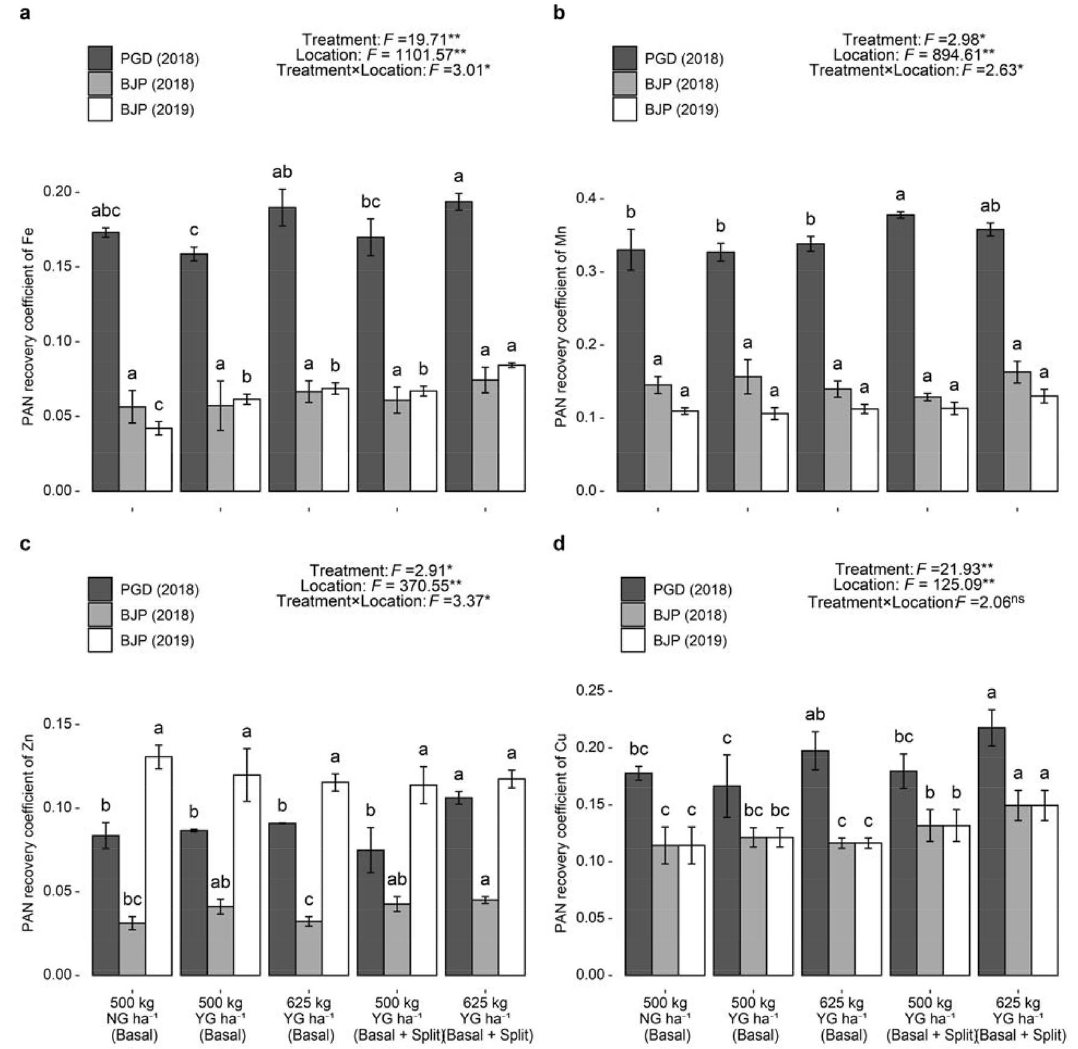
Figure 4. Plant available nutrient (PAN) recovery coefficient of Fe ( a ), Mn ( b ), Zn ( c ) and Cu ( d ) in groundnut under different YG treatments. F value and significance level (** P < 0.01, * P < 0.05 and ns P ≥ 0.05). Values followed by a different letter within the same location are significantly different at P < 0.05 probability level. Capped bars at the surface of vertical bars represent the standard deviation, n = 3. YG yellow gypsum, NG natural gypsum, PGD Pavagada, BJP